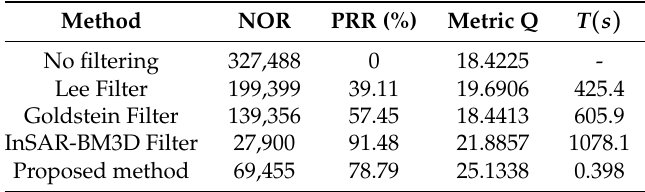
Figure 19. TerraSAR-X data: a real interferometric phase image. Table 6. Quantitative indexes of four methods on TerraSAR-X